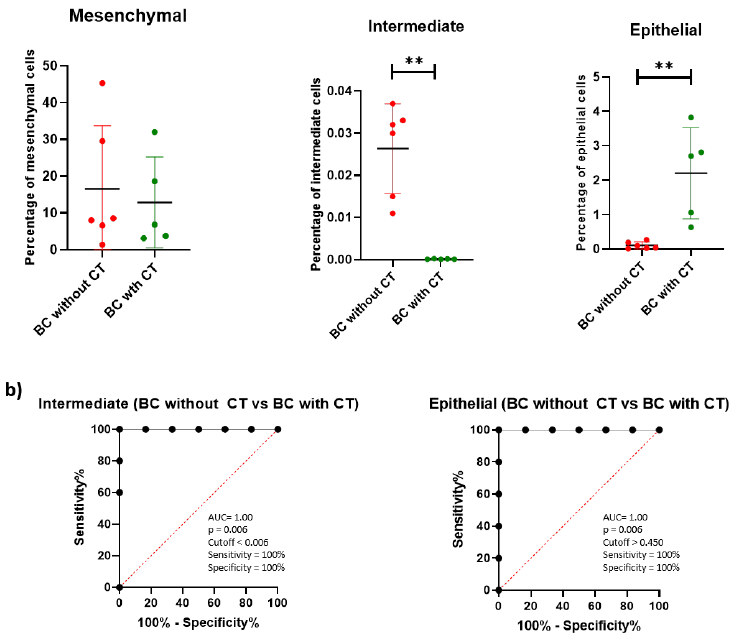
Figure 3. Panel for treatment monitoring. ( a ) Scatter plot of percentage of mesenchymal CTCs (CD45- epithelial 6- mesenchymal 6+ mesenchymal 2+), intermediate CTCs (CD45- epithelial 6+ mesenchymal 6+ mesenchymal 2+), and epithelial CTCs (CD45- epithelial 6+ mesenchymal 6- mesenchymal 2-) for breast cancer without treatment (red) and breast cancer with treatment (green). The line represents the median, and the error bars (whiskers) represent the percentiles (** p < 0.005, comparison of groups via the Mann–Whitney test). ( b ) ROC curves made from the percentage of intermediate CTCs and epithelial CTCs for BC without CT vs. BC with CT. Results about area under the curve (AUC), p value, cutoff, sensitivity, and specificity are being shown near the ROC